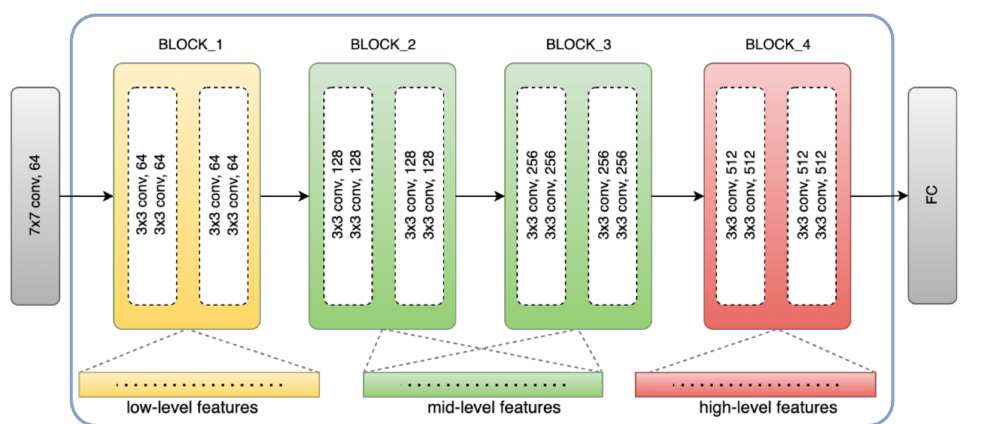
Figure 4. Multi-level feature representation from three different blocks of